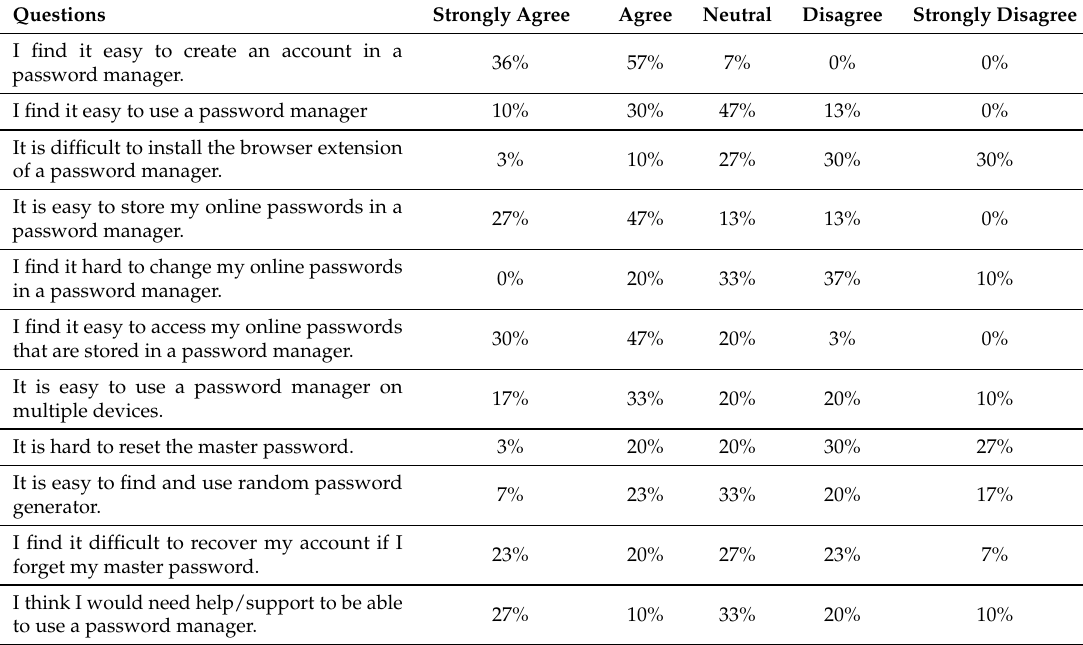
Table 4. 11 questions were answered by 30 participants about using LastPass and specific functions.